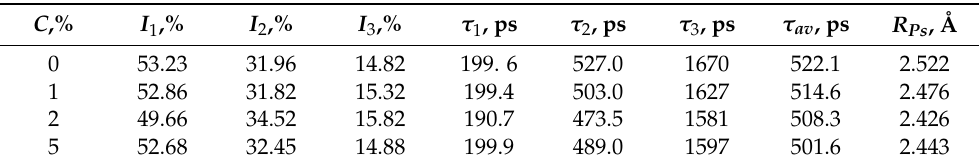
Table 1. Positron annihilation parameters for epoxy and its composites with 1, 2, and 5% multilayer graphene nanopar ‐ ticles.